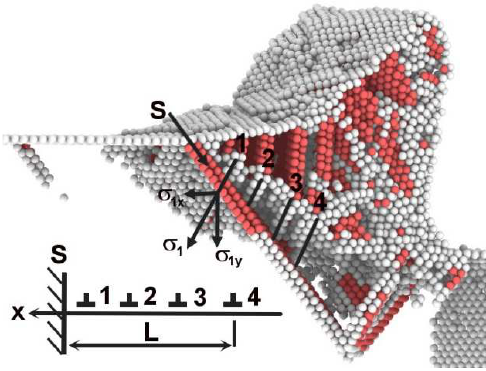
Figure 13. Dislocation block.